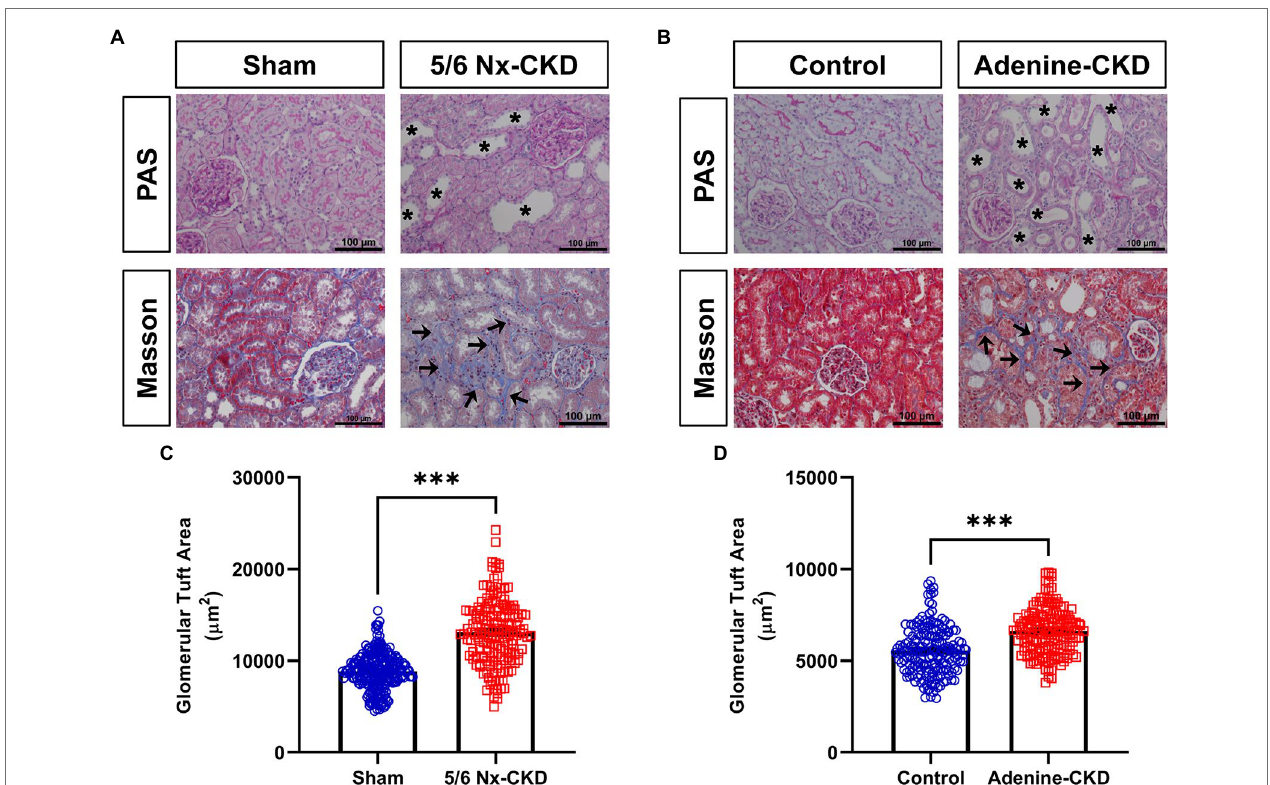
FIGURE 2 | Pathological analysis of kidney tissue structure. (A) Representative images of periodic acid-Schiff (PAS) and Masson staining in sham and 5/6 Nx- induced CKD rats. (B) Representative images of PAS and Masson staining in control and adenine-induced CKD rats. All images are shown at identical magnification, ×200, scale bar = 100 μ m. Asterisk indicates tubular expansion, and arrow indicates collagen fibril. (C) Glomerular tuft area in sham and 5/6 Nx-induced CKD rats. (D) Glomerular tuft area in control and adenine-induced CKD rats. Data are presented as the means ± SEM, n = 150–200 glomeruli from four rats per group ( *** p < 0.001 between the indicated two